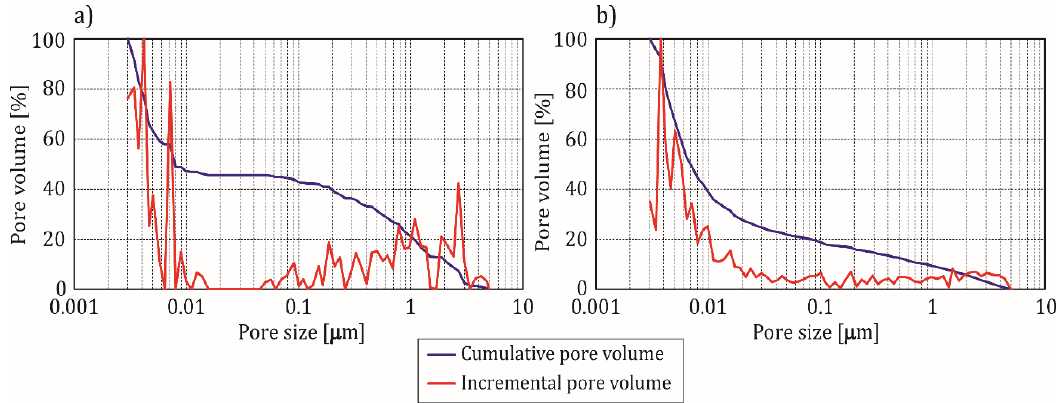
Figure 7. Cumulative and incremental pore volume (MIP); ( a ) Well-1(26) sample; ( b ) Well-2(7) sample.